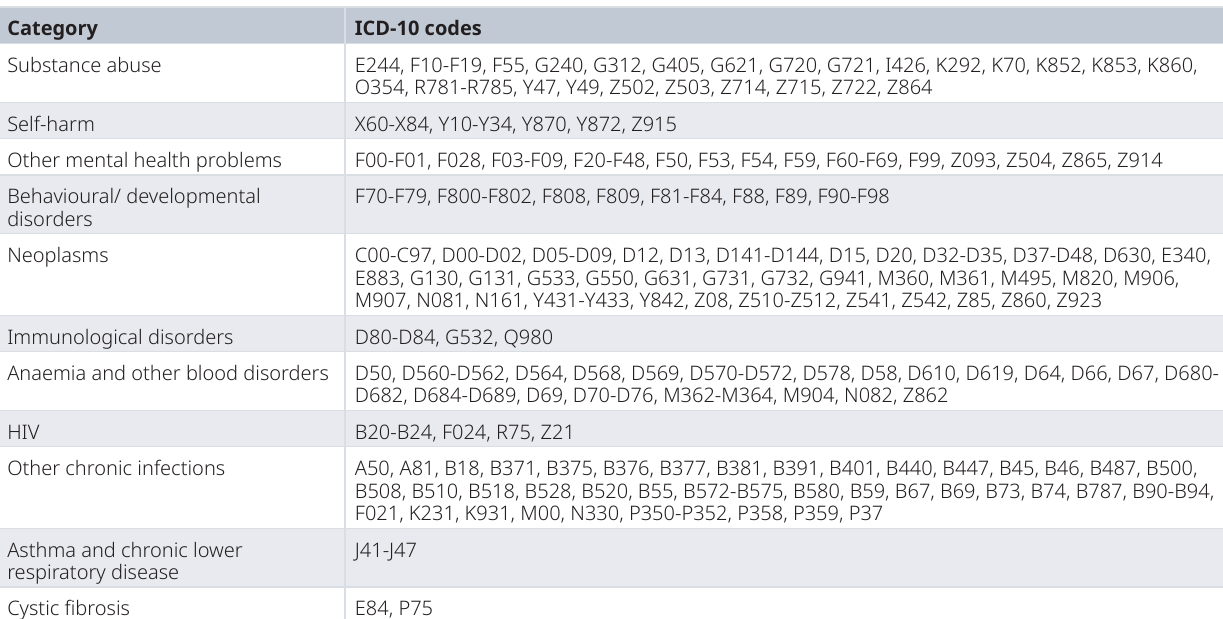
Table 2. Grouping of chronic conditions to count numbers of distinct chronic